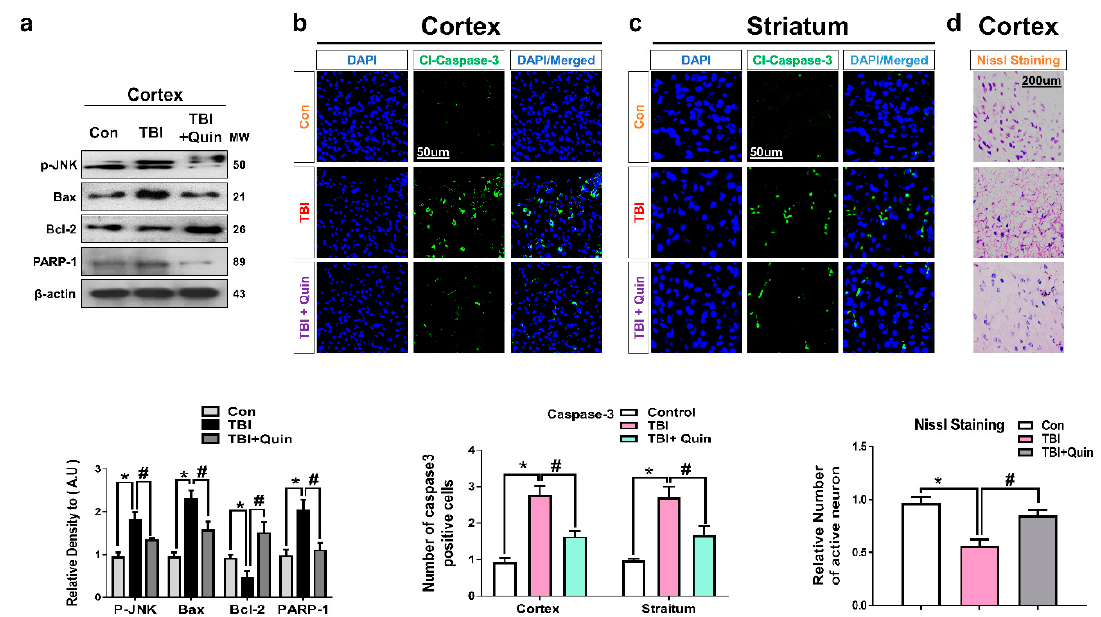
Figure 4. Quinpirole inhibits brain injury-induced neuronal apoptosis in mice brain. ( a ) Representative images showing results of immunoblot and histogram analysis of p-JNK, Bax, Bcl-2, and PARP-1 proteins in the ipsilateral cortex of injured mouse brain. The β -actin was used as a loading control ( n = 5). ( b , c ) Immunofluorescence test images showing cl-caspase-3 immunoreactivity in the ipsilateral cortex and striatum of injured mouse brain, (green, FITC; blue, DAPI) with respective bar graphs, (magnification × 10, n = 6). ( d ) Nissl stain images of the ipsilateral cortex. ImageJ software was used for immunohistological analysis. Data were obtained following three independent experiments. The ImageJ software was used for quantitative analysis of the nissl images and confocal microscopy images. The integrative density of the number of caspase3 positive cells were quantified in the representative field. Values are expressed as mean ± SEM. We performed the one-way ANOVA test followed by post-hoc analysis. A p value < 0.05 was considered statistically significant. * significantly different between the control and brain injury groups, # significantly different between the brain injury and quinpirole-treated groups. ANOVA: analysis of variance, SEM: standard error of mean.